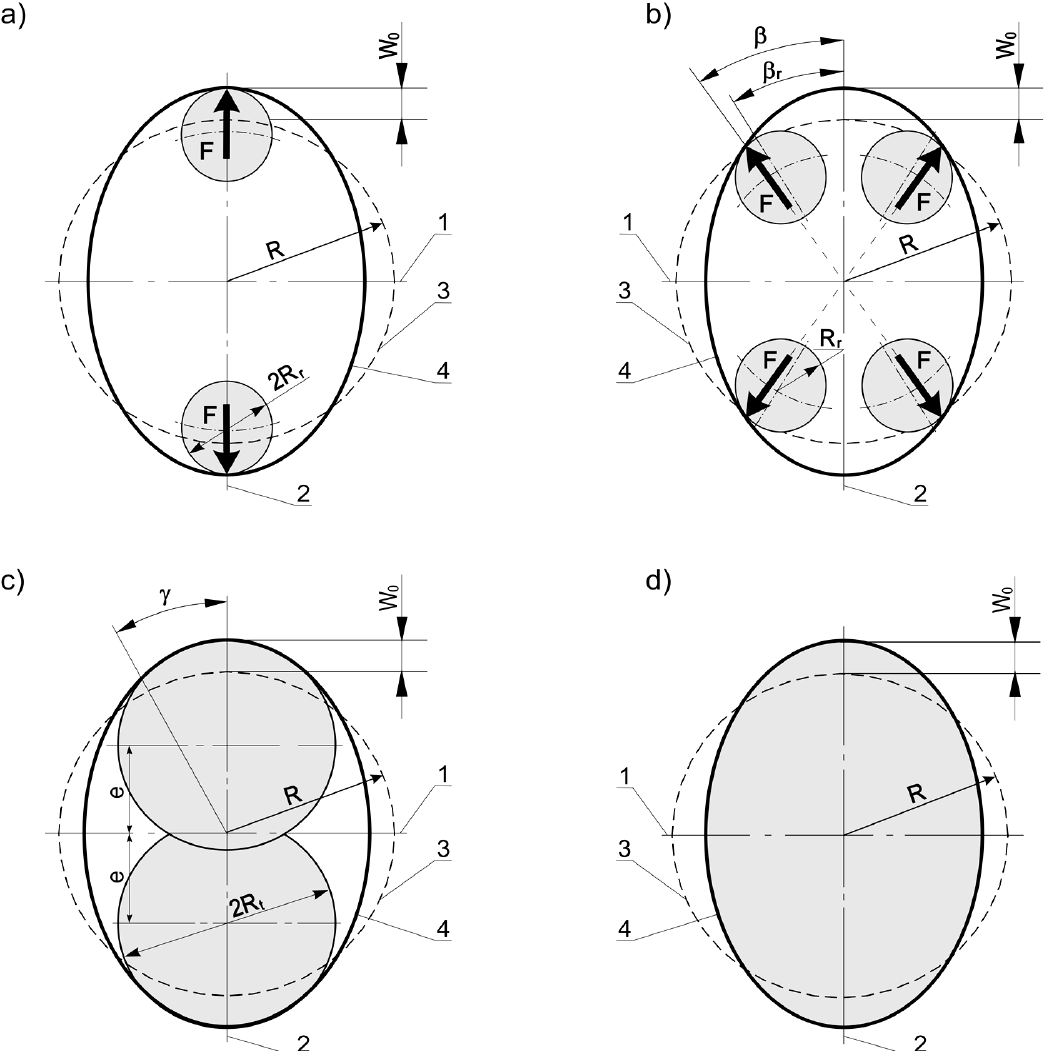
Figure 3. Forms of deformation of the neutral layer of a flexspline deformed by the generator: ( a ) two-roll, ( b ) four-roll, ( c ) disc, ( d ) cam, where: 1 — minor axis of generator, 2 — large axis of generator, 3 — neutral layer of flexspline body before deformation, 4 — neutral layer of flexspline body after deformation, R — radius of undistorted interlayer of flexspline, R r — radius of roll of generator, R t — radius, e — eccentricity of the disc setting, F —force deformation of flexspline in roll generators, β— angle of action of forces in the roll generators, β r — angle of settings of generator rollers, γ— angle of contact of generator with flexspline, w 0 — radial deformation of the neutral layer of flexspline.